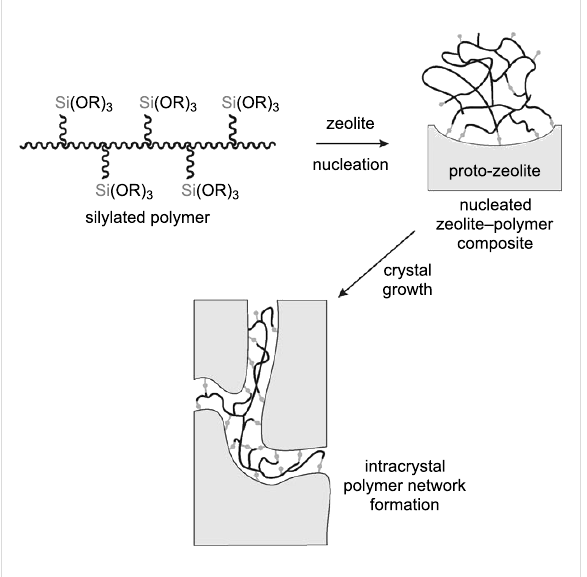
Figure 6: Conceptional approach for the synthesis of a mesoporous zeolite with a silylated surfactant as mesotemplate. Reprinted from [141]. Copyright 2006, with permission from John Wiley and Sons.